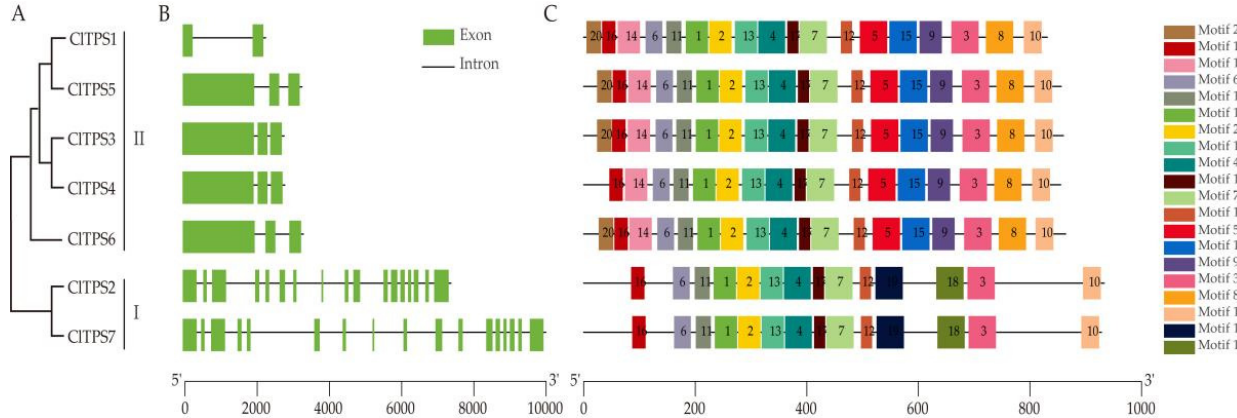
Figure 3. Phylogenetic analysis, gene structure, and conserved motifs of ClTPSs. ( A ) Phylogenetic analysis of seven ClTPSs. ( B ) Exon/intron organization of ClTPSs. ( C ) Conserved motifs of